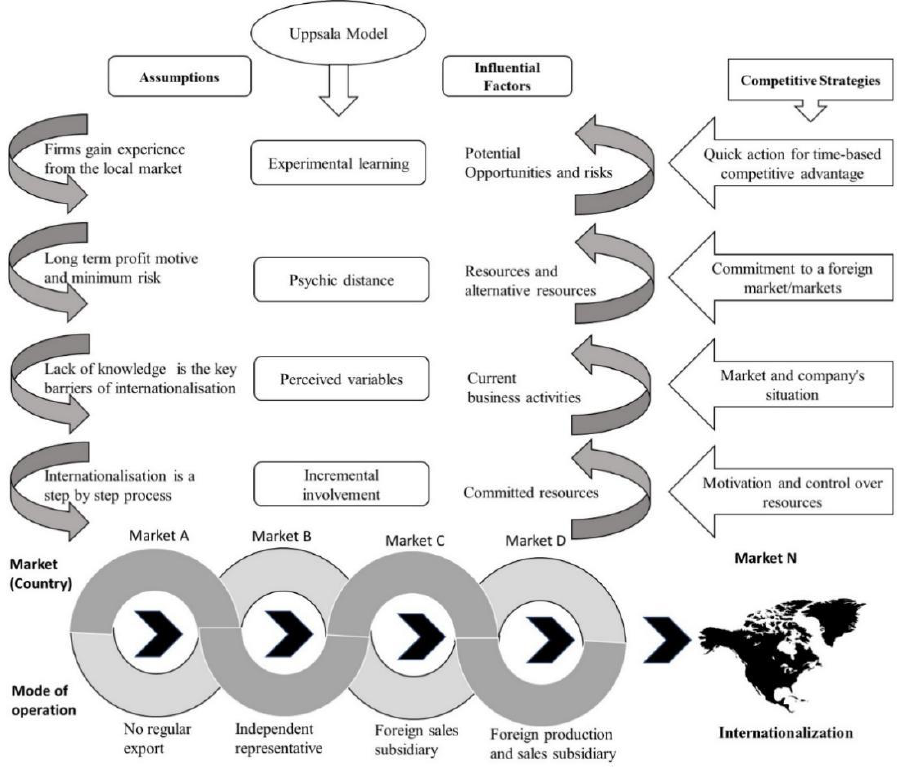
Figure 4. The Triad of Integrated Uppsala Model of Early and Speed of Internationalization. Source: Authors’ framework.